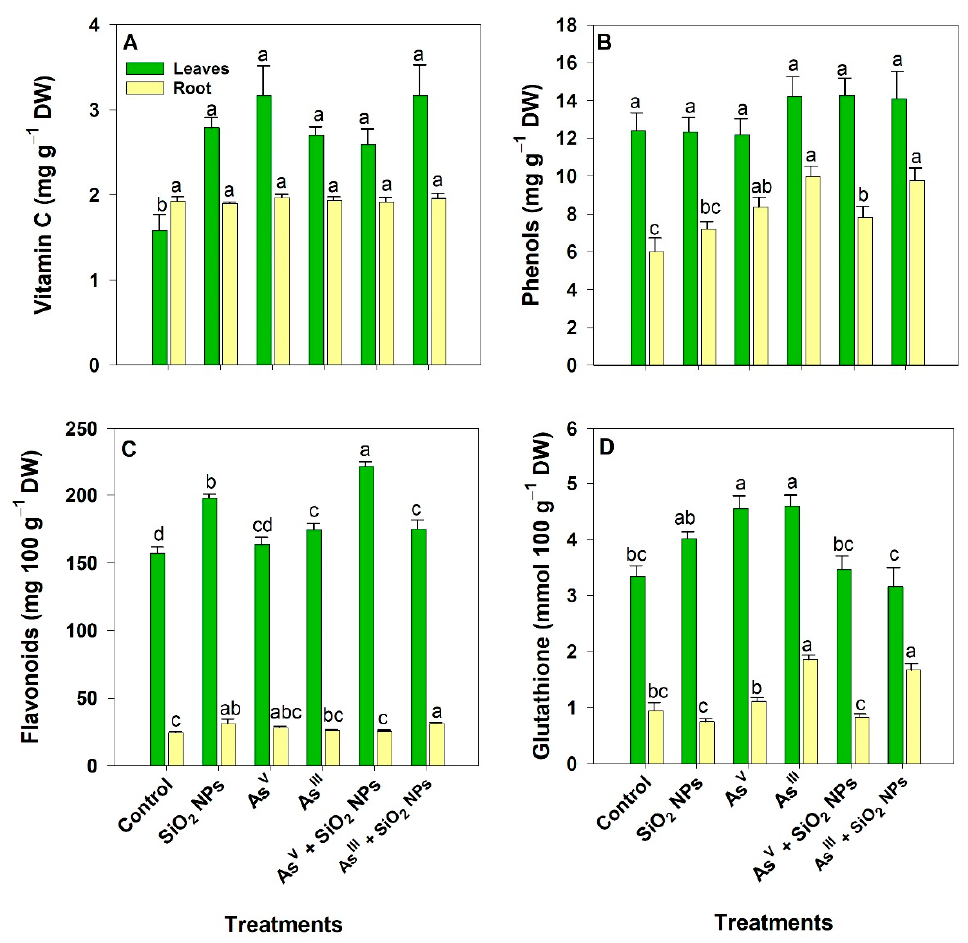
Figure 6. Non-enzymatic antioxidant compounds in tomato roots and leaves exposed to two forms of inorganic As and SiO 2 NPs. ( A ) Vitamin C, ( B ) phenols, ( C ) flavonoids, and ( D ) glutathione. Plants treated with 3.2 mg L − 1 of As V (Na 2 HAsO 4 · 7H 2 O) and As III (NaAsO 2 ) via irrigation through the nutrient solution and 1000 mg L − 1 of SiO 2 NPs via substrate. Lower-case different letters per bar indicate statistical differences according to the Fisher’s least significant difference test ( p ≤